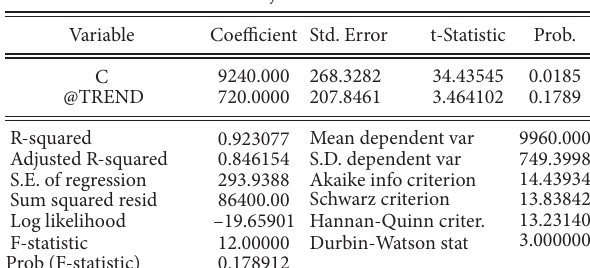
Figure 1: EViews software and waste estimation